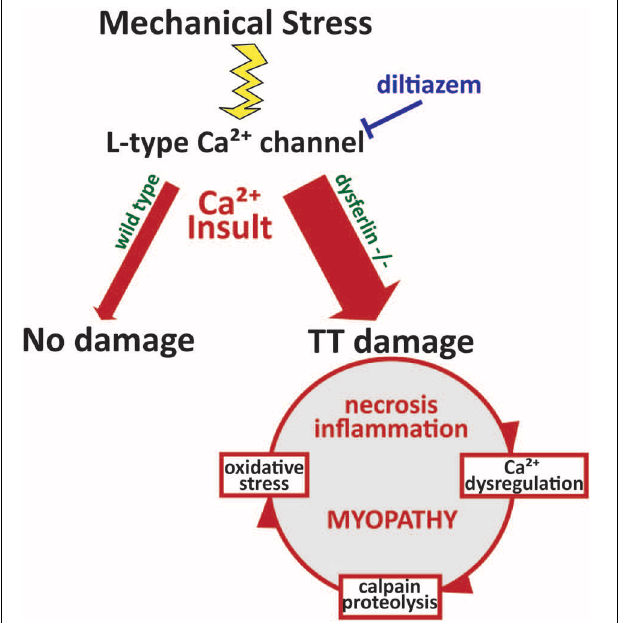
FIGURE 2 | Pathophysiology of dysferlin deficiency. Dysferlin is hypothesizedtorespondtoinfluxesofCa 2 + andpromotewoundrepairofthe t-tubulemembrane.Mechanicalstressormembraneinjuryresultsininfluxof Ca 2 + , mediated by the L-type Ca 2 + channel, and this Ca 2 + influx does not cause significant muscle injury in wild type muscle cells. However, in the absence of dysferlin, Ca 2 + influx to the cytosol is greatly exaggerated, disrupting Ca 2 + homeostasis and EC-coupling. This activates a cascade of Ca 2 + -mediated events that promote further damage to the muscle fiber, including Ca 2 + -induced proteolysis and oxidative stress. Together, these processes contribute to the eventual myopathy, spurring increased necrosis and